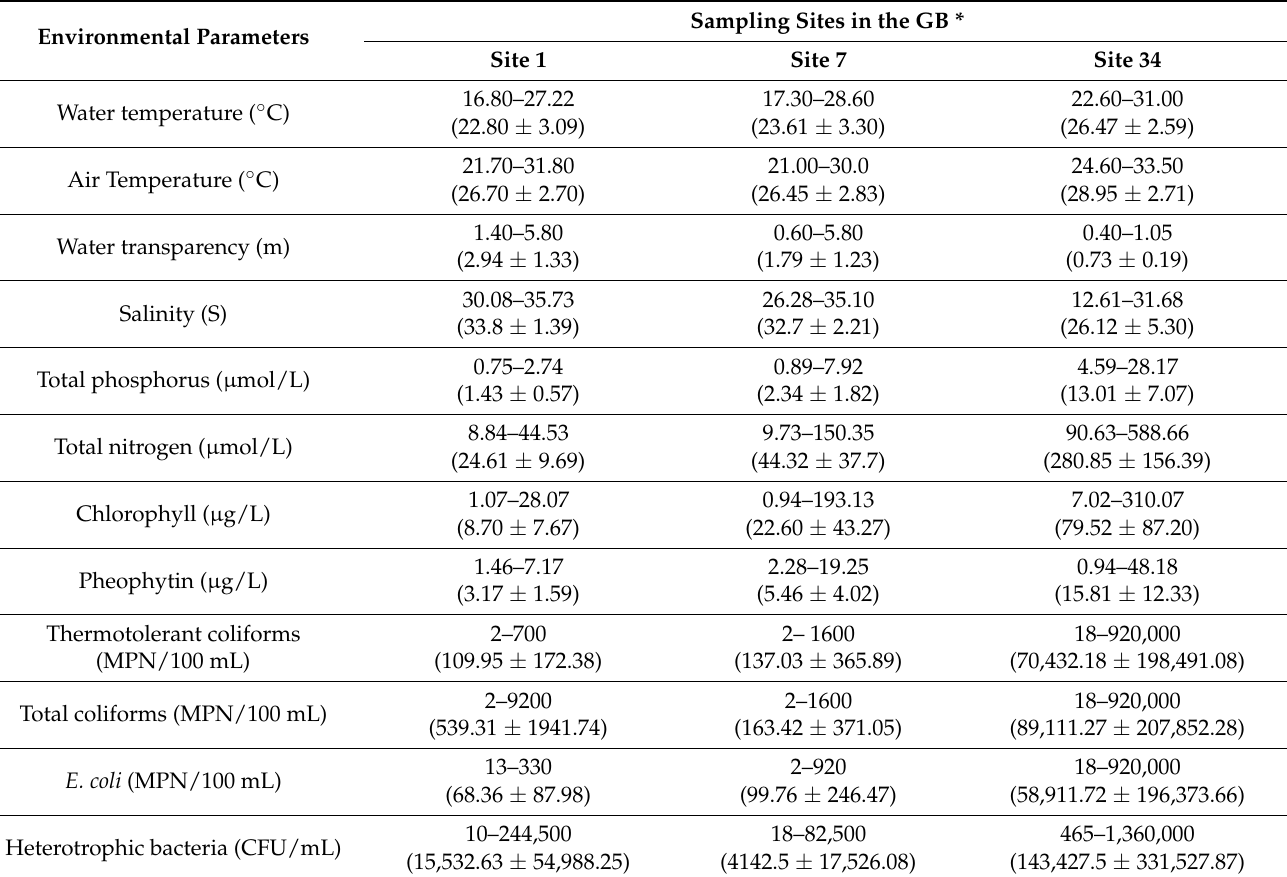
Table 3. Environmental parameters from 2018 to 2019 in Guanabara Bay’s waters. Minimum, maximum, average values and standard deviation of environmental parameters in each sampling